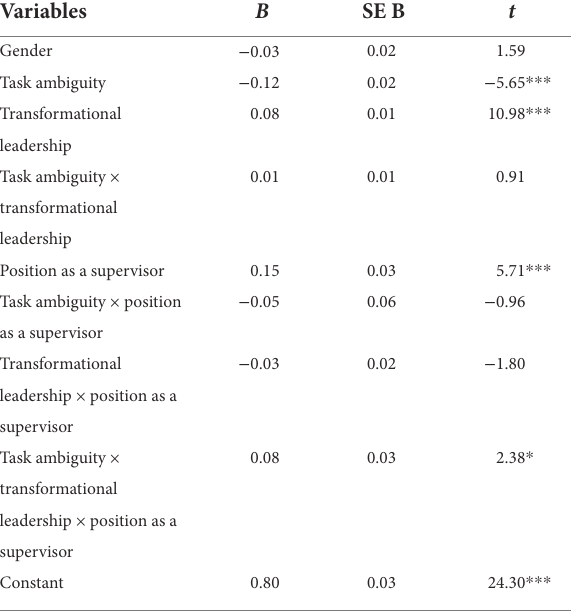
TABLE 2 Two-and three-way interactions between role ambiguity, transformational leadership, and position as a supervisor regarding job satisfaction in Study 1 ( N = 845); R 2 =